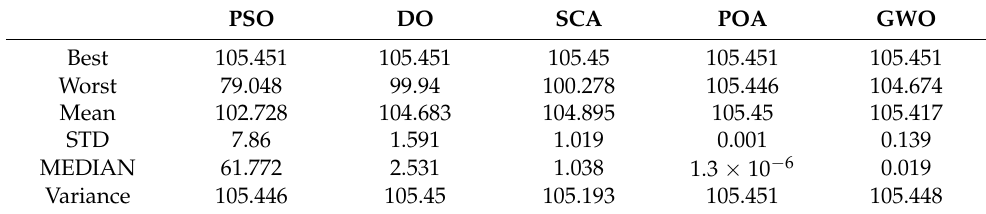
Table 4. Statistical analysis of the five considered optimizers.